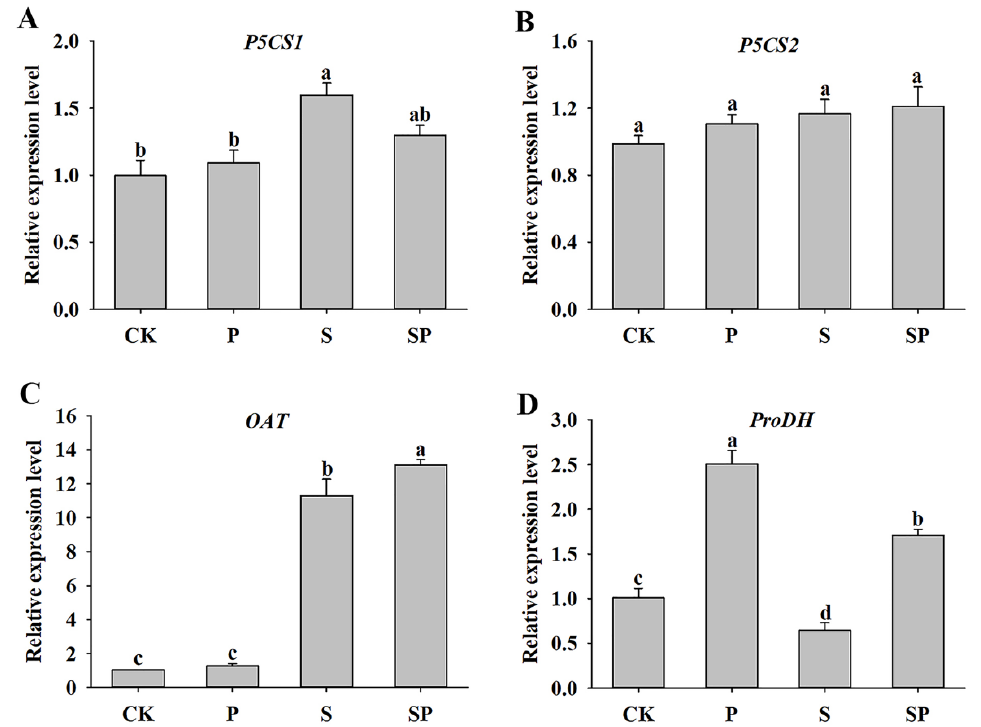
Figure 4. Effects of proline (30 mM) treatment on the expression levels of P5CS1 ( A ), P5CS2 ( B ), OAT ( C ), and ProDH ( D ) of alfalfa under salt stress. Data are means ± SE ( n = 3), and different letters indicate significant differences between groups ( p < 0.05).